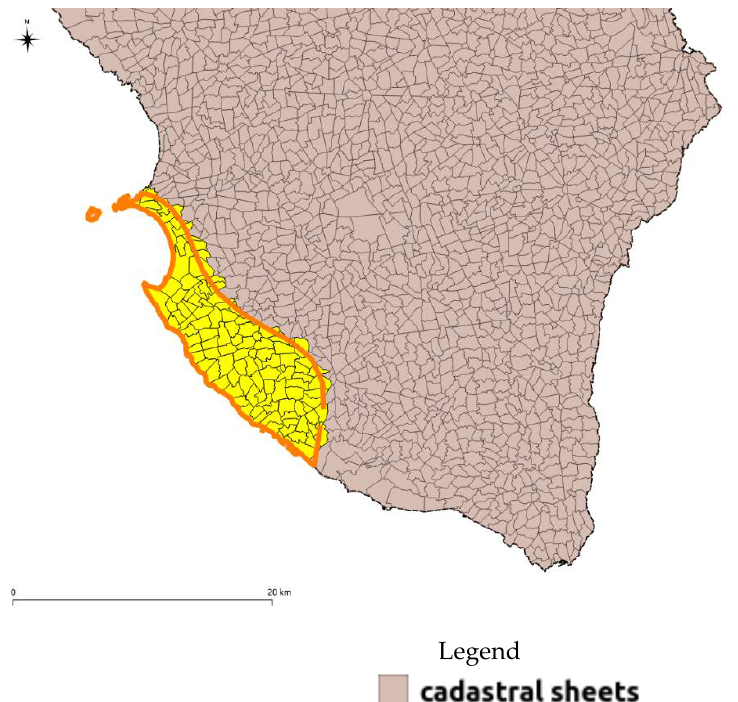
Figure 9. Example of final perimeter of groundwater bodies with identification of cadastral sheets for a simplified administration of the NVZs .